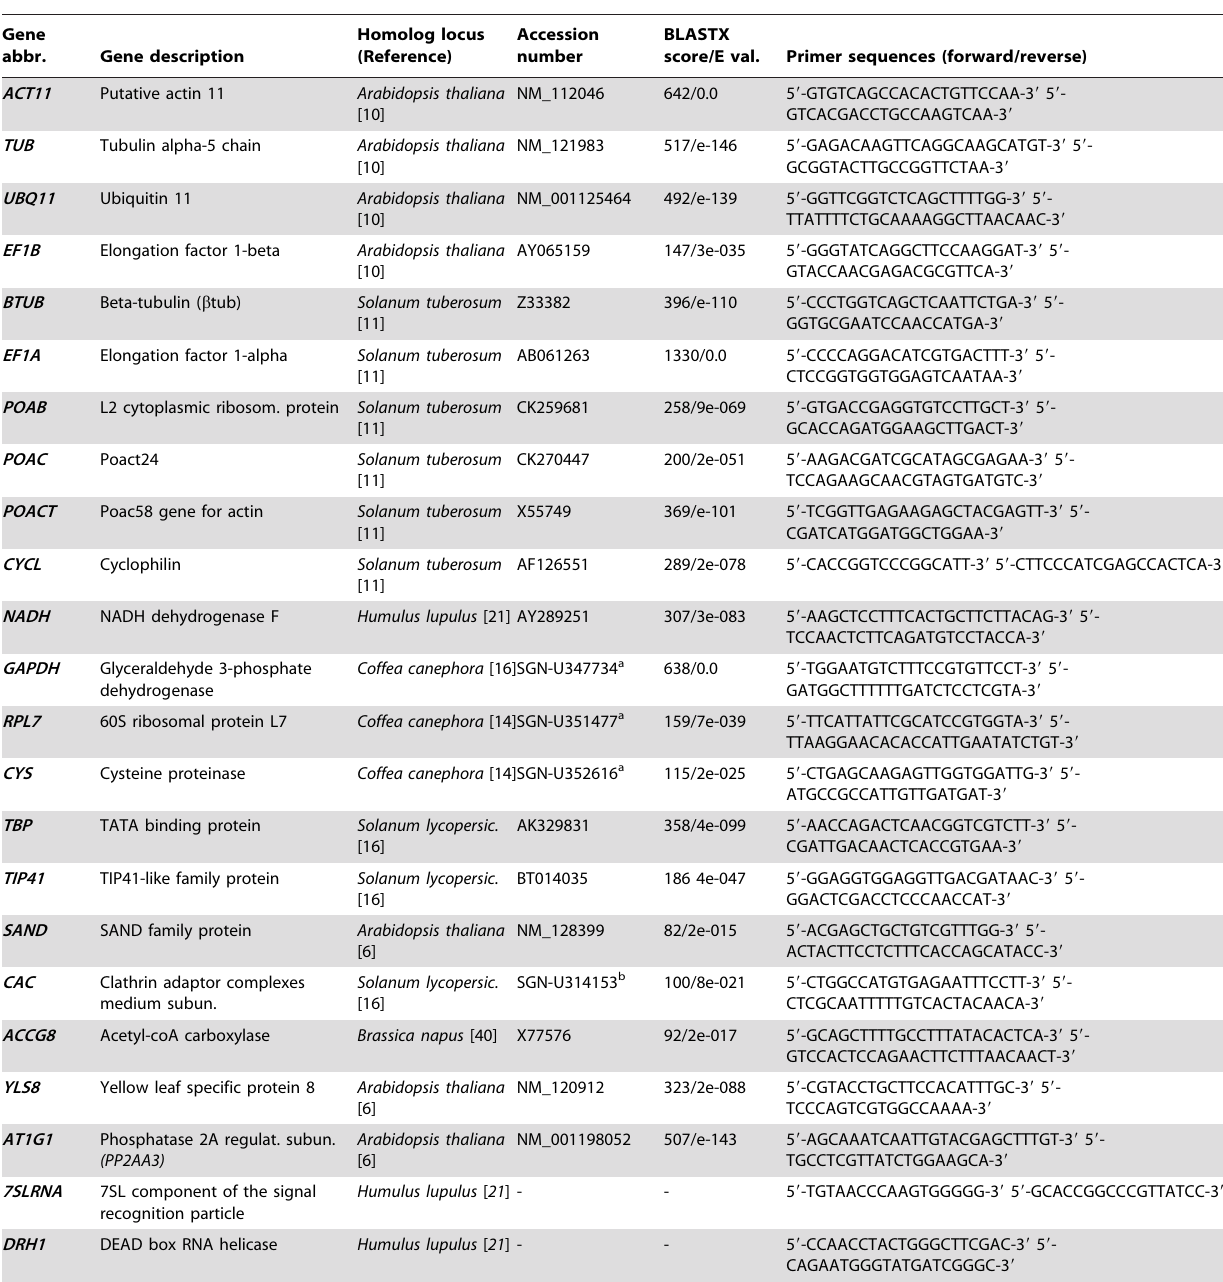
Table 1. Primer sequences of 23 reference genes that were designed for qPCR amplification.